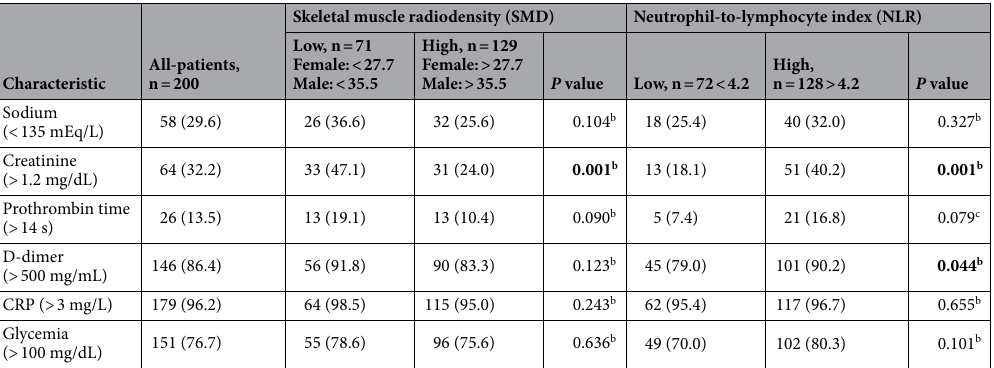
Table 1. Selected demographic and clinical characteristics, as well as laboratory findings according to skeletal muscle radiodensity (SMD) and neutrophil-to-lymphocyte ratio (NLR) of patients with COVID-19. Missing data: ALT: 7; sodium: 4; creatinine: 1; prothrombin time: 7; D-dimer: 31; CRP: 14; and glycemia: 3 ALT alanine aminotransferase, BMI Body mass index, CRP C-reactive protein, SD standard deviation. a Student’s t -test. b chi- squared test. c Fisher’s exact test. Bold indicates P value is statistcally significant.